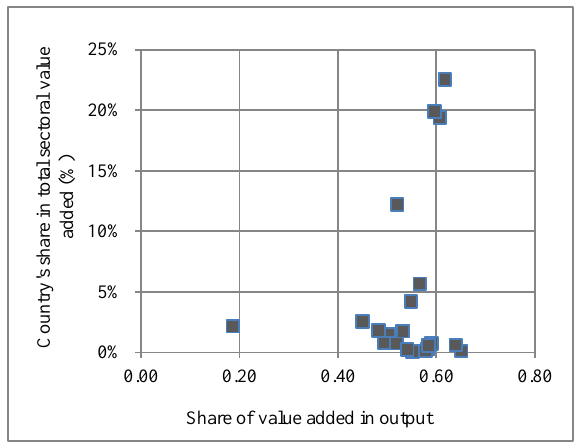
Fig. 5. Computer programming, consultancy, and information service activities in the EU in